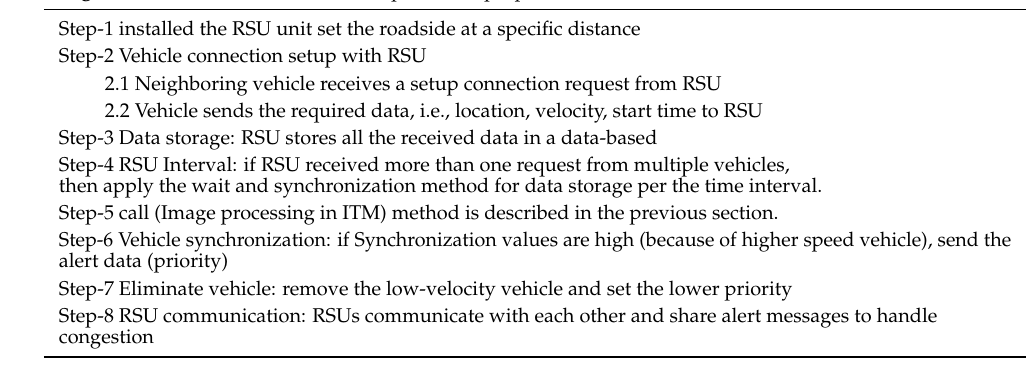
Algorithm 2: Vehicle communication process in proposed